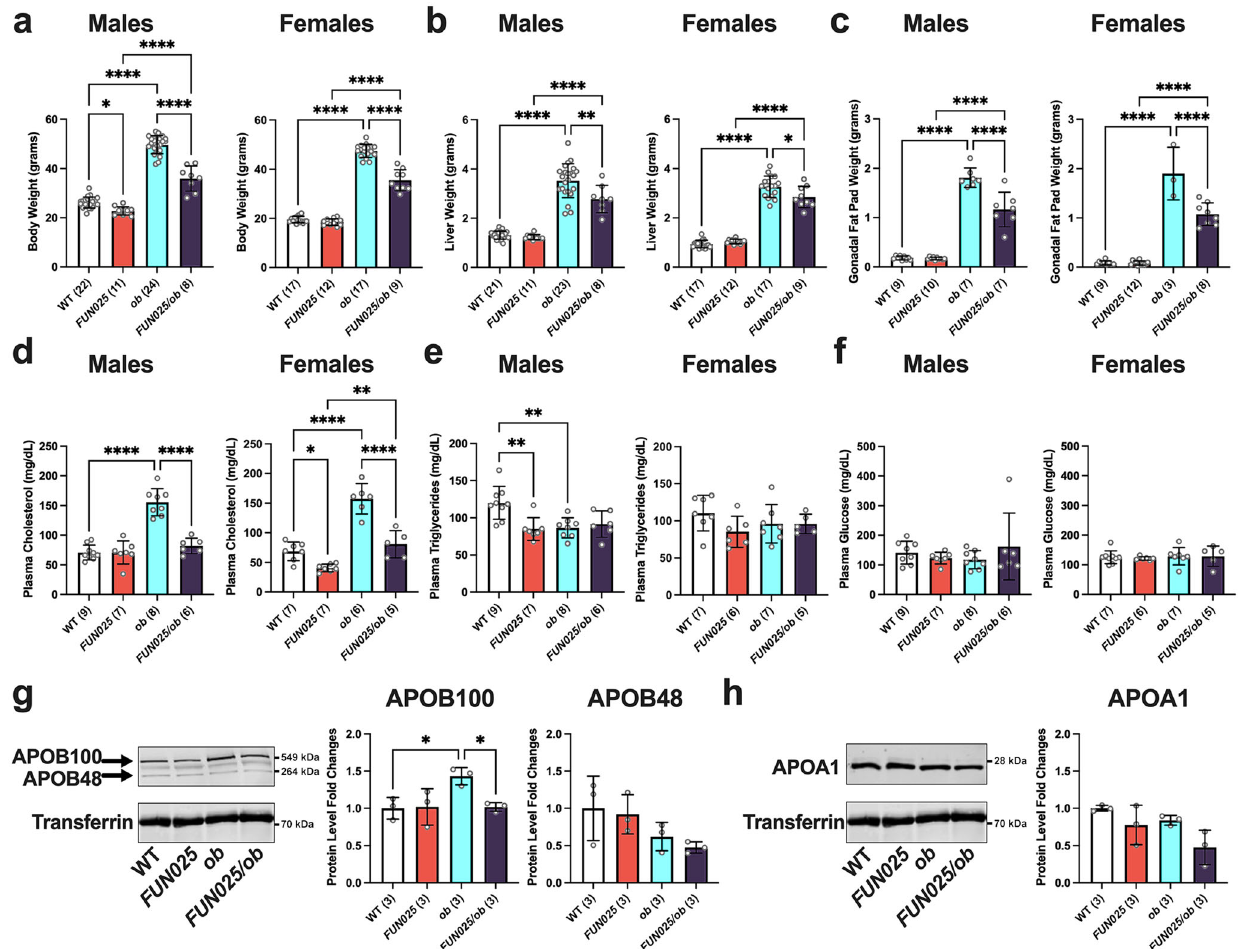
Fig. 7 Tmem135 mutation reduces leptin mutation-induced obesity and dyslipidemia. a Body, b liver, and c gonadal fat pad weights as well as d plasma cholesterol, e plasma triglyceride, and f plasma non-fasting glucose levels of 3-month-old WT, Tmem135 FUN025/FUN025 ( FUN025 ), Lep ob/ob ( ob ), and Tmem135 FUN025/FUN025 / Lep ob/ob ( FUN025/ob ) male and female mice. Western blot analysis of plasmas from 3-month-old WT, Tmem135 FUN025/FUN025 , Lep ob/ob , and Tmem135 FUN025/FUN025 / Lep ob/ob male mice for g apolipoprotein B100 (APOB100) and B48 (APOB48) and h apolipoprotein A1 (APOA1). Transferrin served as a loading control for these experiments. Number in parentheses represent the N of independent mice or mouse samples per genotype used in the experiment. Dots represent individual data points. The protein size next to the immunoblot images denotes the size of the immunoband measured for this analysis. Asterisks (*, **, and ****) indicate a P < 0.05, P < 0.01, and P < 0.0001 signi fi cance by post hoc Tukey test following a signi fi cant difference detected by one-way ANOVA. Data are presented as mean ±